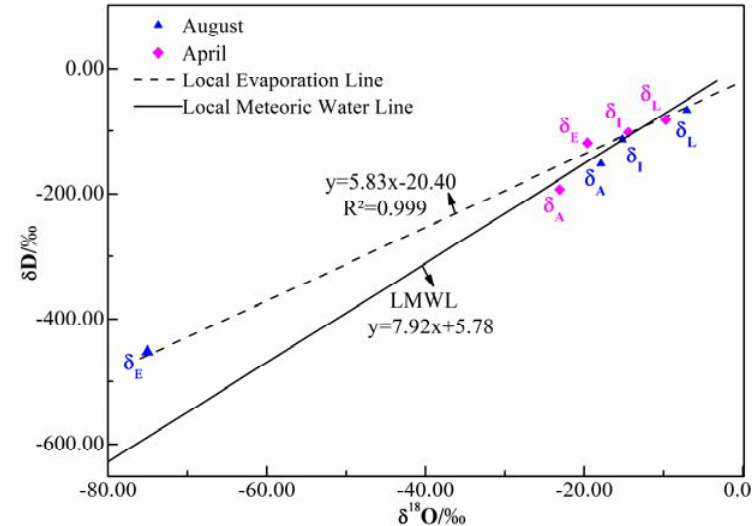
Figure 9. Schematic δ 18 O and δ D diagram identifying key isotopic parameters used in isotope-mass balance studies. These include lake water isotope composition ( δ L ), isotope composition of evaporated vapor from the lake ( δ E ), input water isotope composition ( δ I ). The atmospheric moisture isotope composition ( δ A ) is also shown.